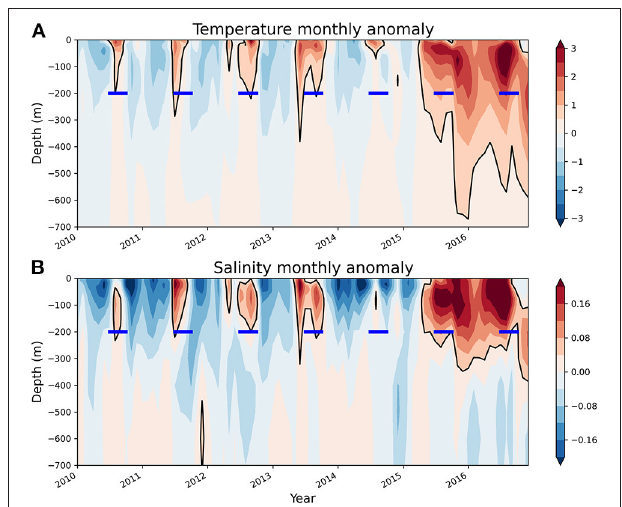
FIGURE 10 | Monthly time-depth diagram from 2010 to 2016 of (A) temperature and (B) salinity anomaly ( ◦ C and salinity unit, respectively; colors and contours) horizontally averaged in the box in Figures 8 , 9 . The horizontal blue lines at 200m depth denote JAS period each